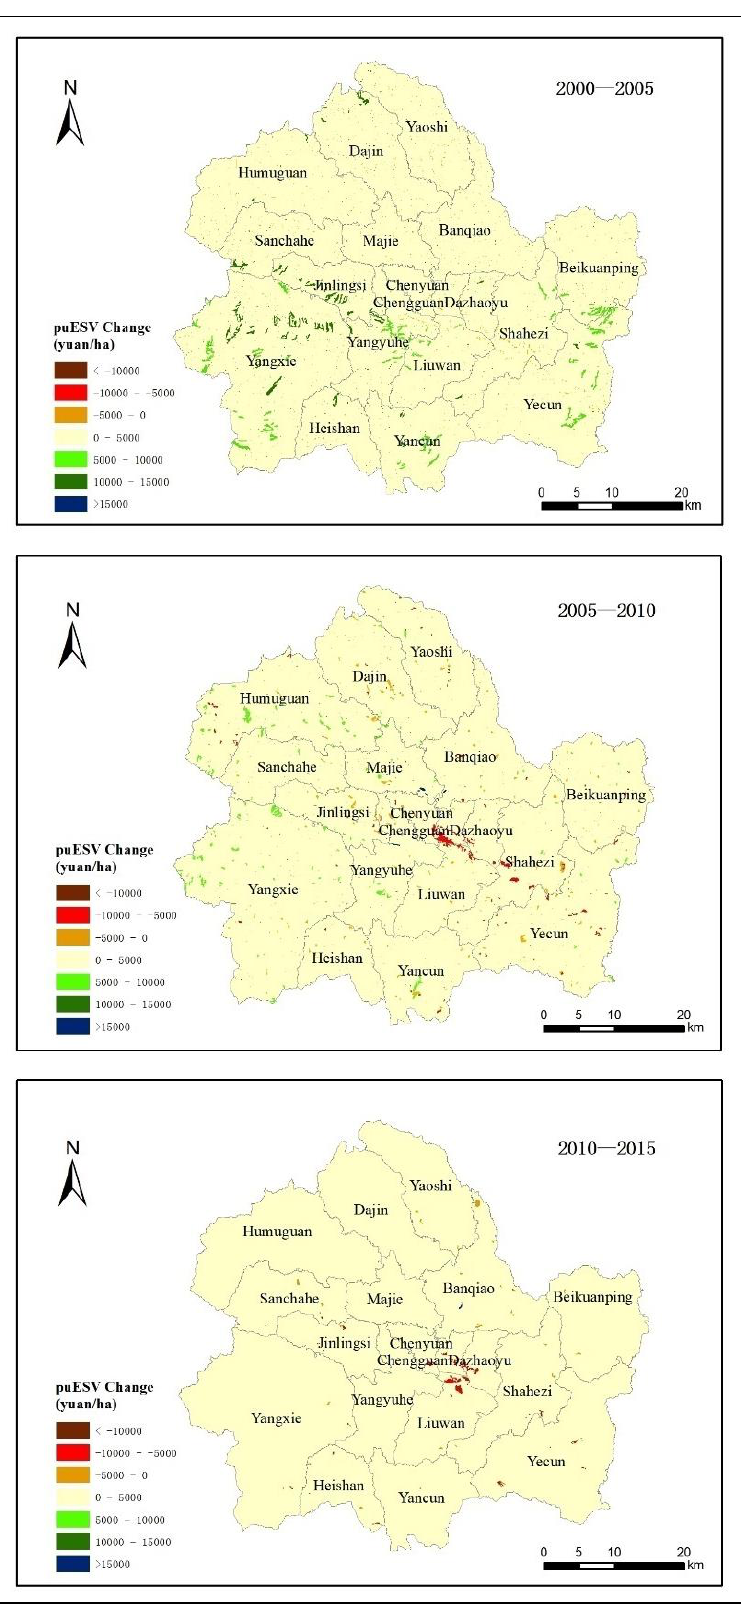
Figure 5. Changes in ecosystem service value in Shangzhou district from 2000 to 2015.